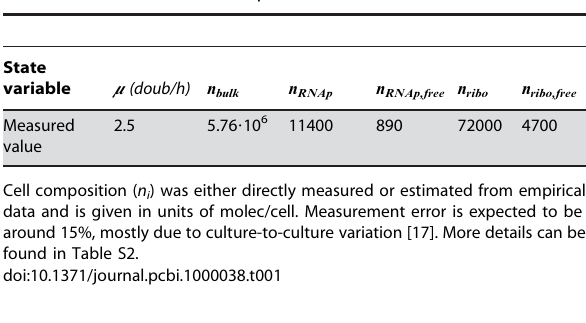
Table 1. The cell state at m =2.5 doub/h, 37 u C.